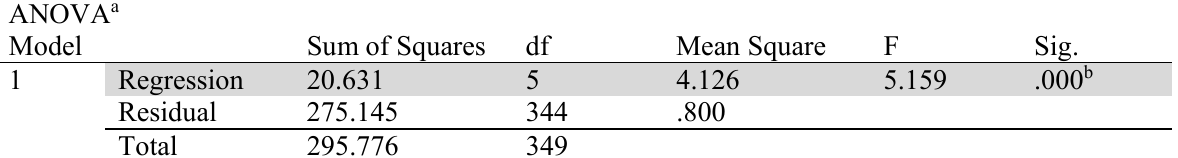
ANOVA table for the regression